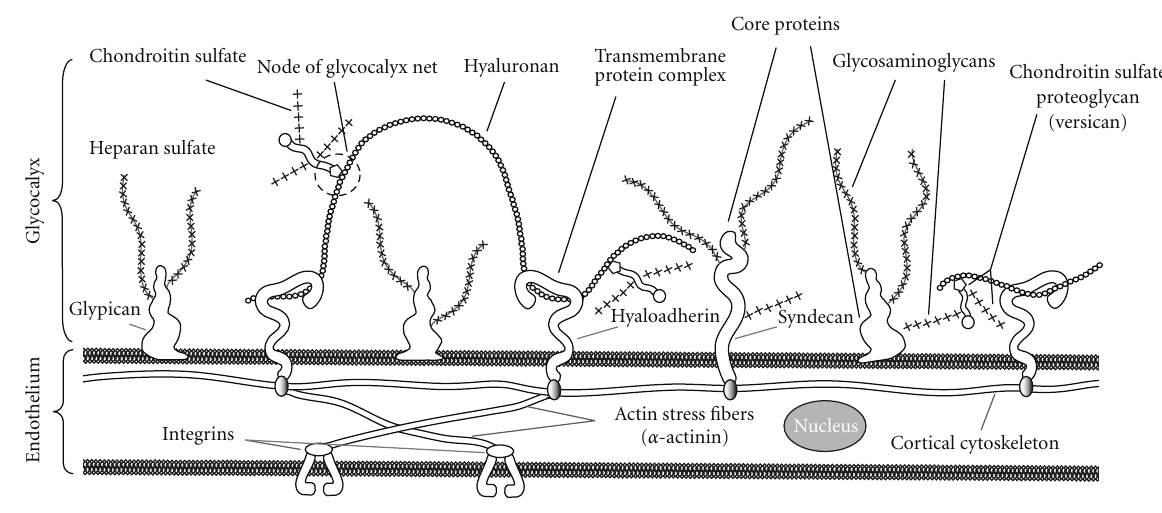
Figure 2: Schematic representation of the glycocalyx meshwork associated with cytoskeleton. Hyaluronan weaves into glycocalyx and binds with hyaladherins (CD-44 (hyalreceptor), RHAMM (receptor for hyaluronan-mediated motility), other proteins, or hyaluronansynthases). Chondroitin sulfate proteoglycan (versican) interacts with hyaluronan to form high molecular mass stable aggregates. Enhanced formation of hyaluronan-versican pericellular coat is observed under pathophysiological conditions (inflammation, early atherosclerosis, restenosis, plaque thrombosis, and